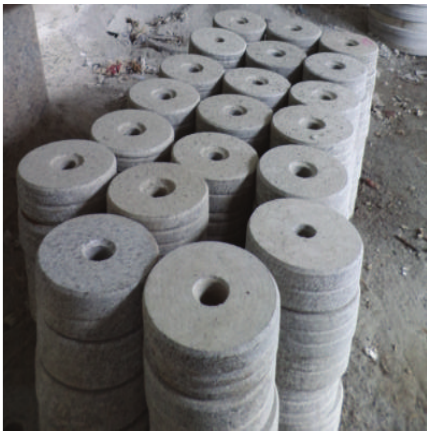
Figure 1: WSD processing unit.